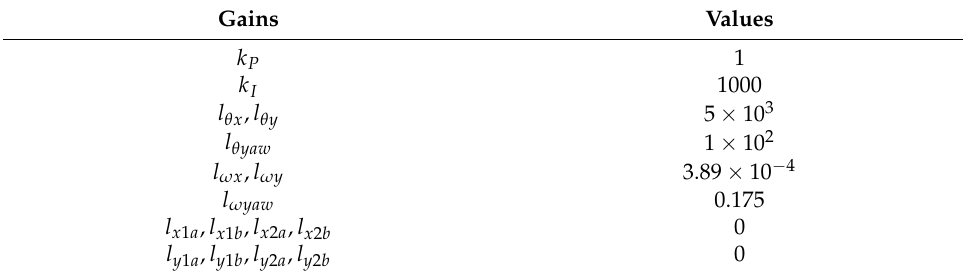
Table 2. Control gains and nonlinear observer